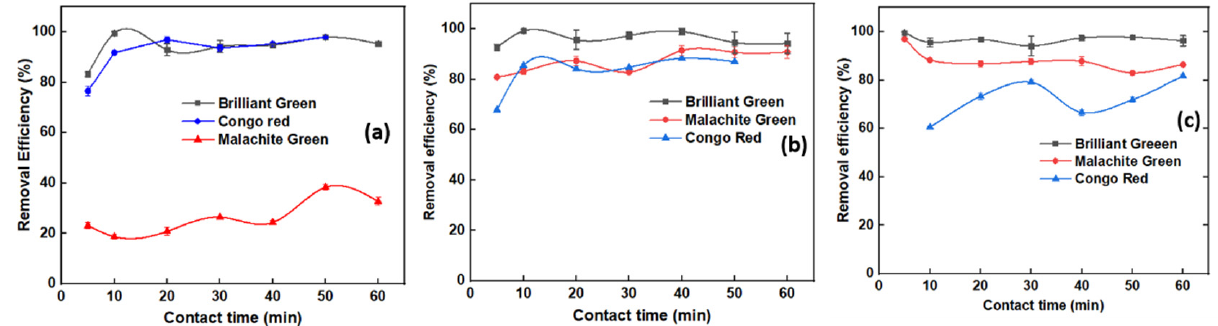
Figure 7. Effect of removal of BG, MG and CR dyes at different pH conditions. ( a ) Acidic, ( b ) native ( c )